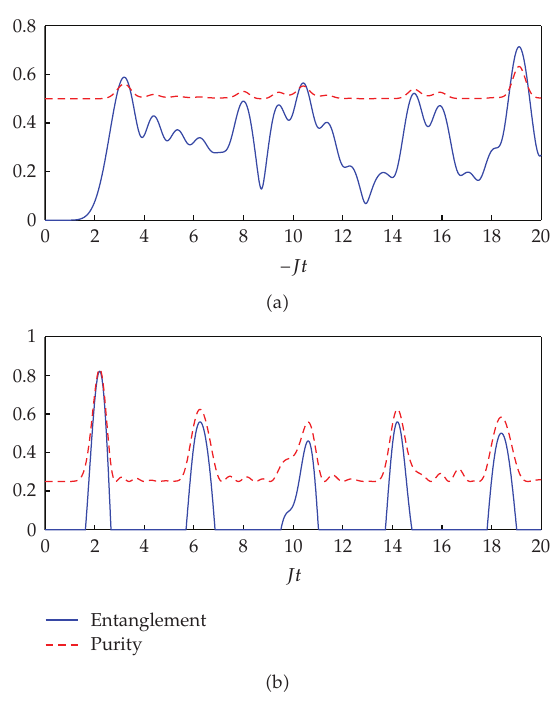
Figure 1: (cid:4) Color online (cid:5) The concurrence and the purity of the state ρ 0 (cid:2) N for the case of FM chain (cid:4) J < 0 (cid:5) and (cid:4) b (cid:5) is for AFM one (cid:4) J > 0 (cid:5) .